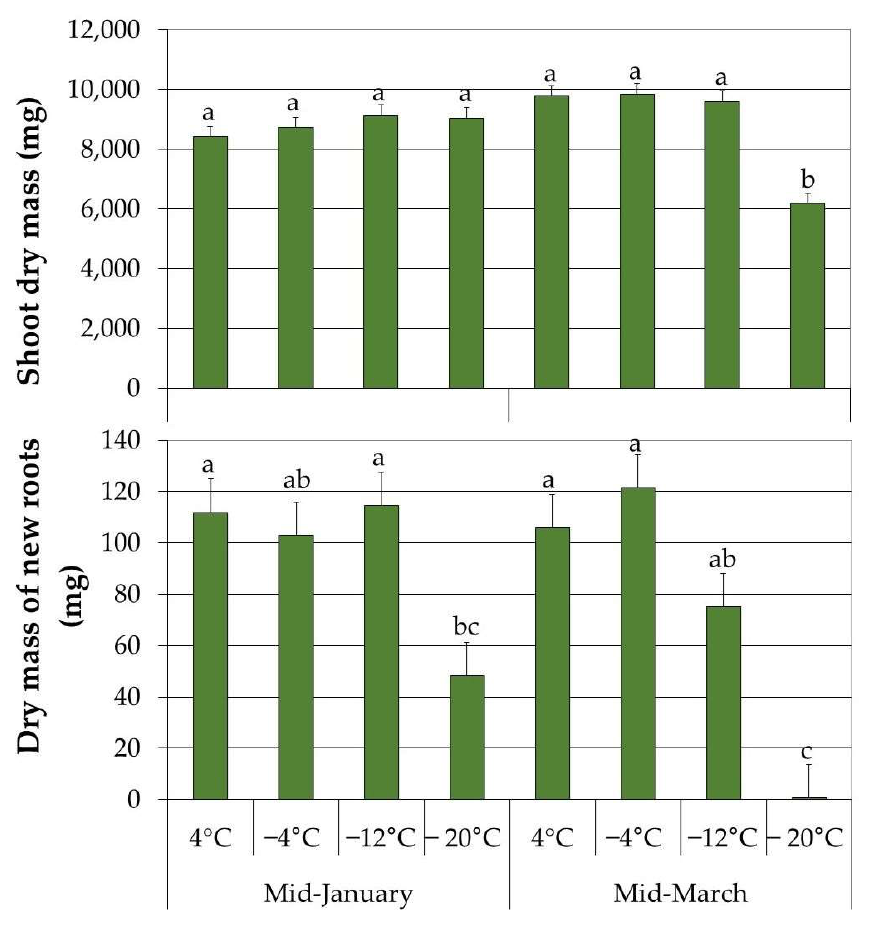
Figure 6. Comparisons of adjusted means ( ± standard error) of dry masses of shoot and new roots of white spruce (2 + 0) in response to whole-seedling freezing temperatures at the beginning (mid-January) and end of winter (Mid-March). The distinct letters show significant differences at the threshold α = 5%, according to a simulation method available in SAS as described by Westfall et al. 47 .